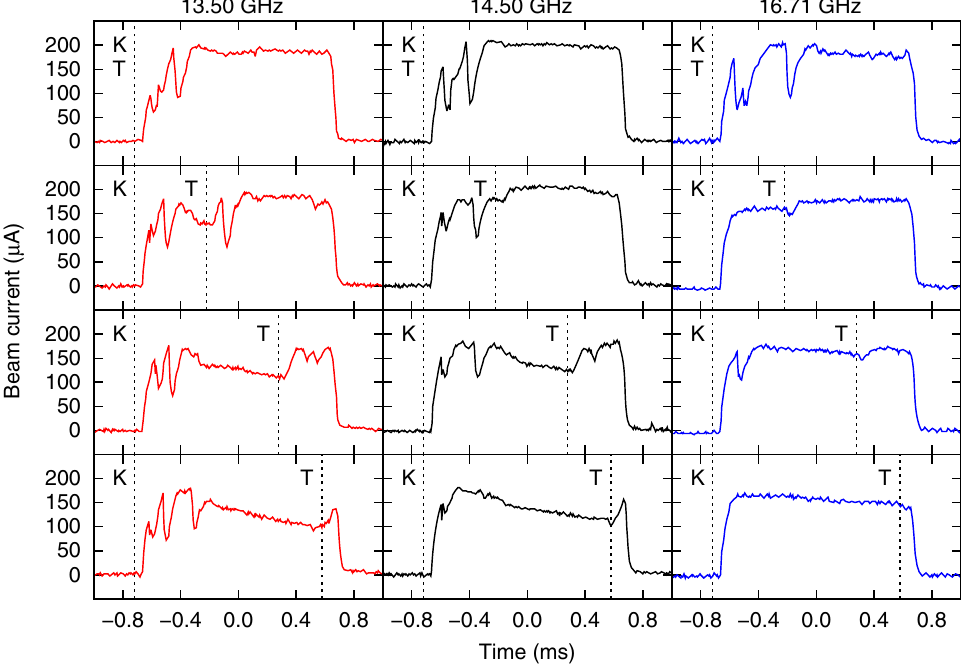
FIG. 12. 208 Pb 29 þ afterglow beam currents with varied secondary frequency (columns) and trailing edge delays between the klystron and the TWTA RF pulses (rows). The presented delays are 0 ms for the first row, 0.5 ms for the second, 1.0 ms for the third and 1.3 ms for the fourth. The dashed vertical lines indicate the trailing edges of the klystron (K) and the TWTA (T) RF